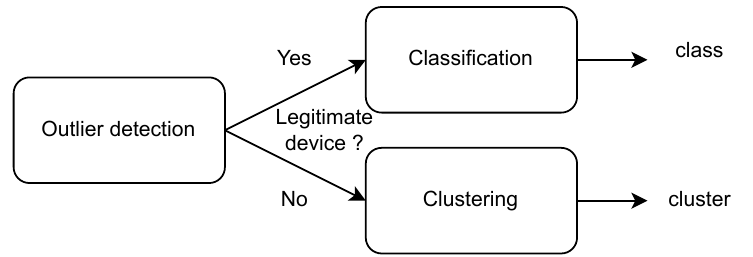
Figure 9. Three-steps decision